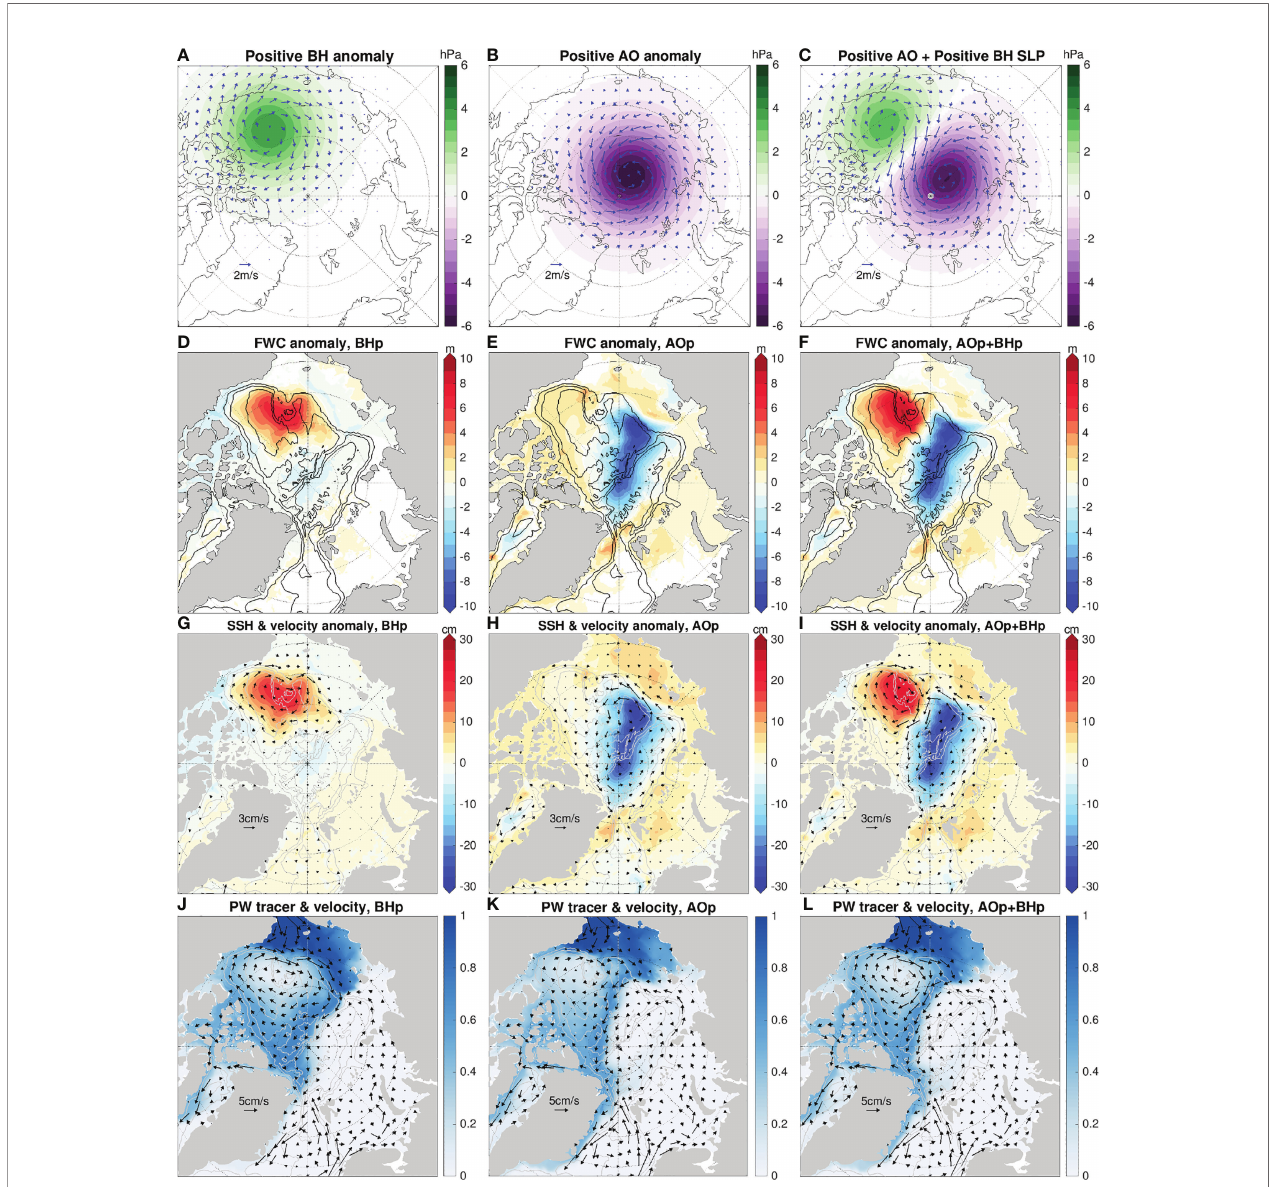
FIGURE 4 | Idealized wind perturbation experiments showing the response offreshwater content (FWC, m), sea surface height (SSH) and upper ocean circulation to winds. (A – C) Sea level pressure [SLP, (color)] and winds [vectors] anomalies representing idealized forcing used in wind perturbation experiments: (A) positive Beaufort High (BH), (B) positive Arctic Oscillation (AO), and (C) positive AO plus positive BH. (D – F) The corresponding FWC anomalies in the last model year. (G – I) The corresponding SSH anomalies [color] and upper 150 m velocity anomalies [vectors]. The anomalies are calculated as the difference between the wind perturbation experiments and the control simulation. (J – L) The corresponding Paci fi c Water (PW) passive tracer concentration [color] and ocean velocity [vectors] averaged over the upper 150 m in the last model year; The control simulation is shown in Figure S3 for